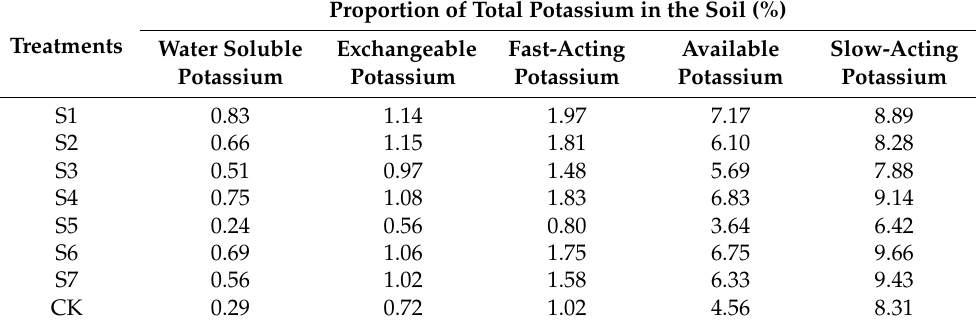
Table 2. Effects of KSB on the proportion of potassium content in rhizosphere soil of Paris polyphylla var. yunnanensis .